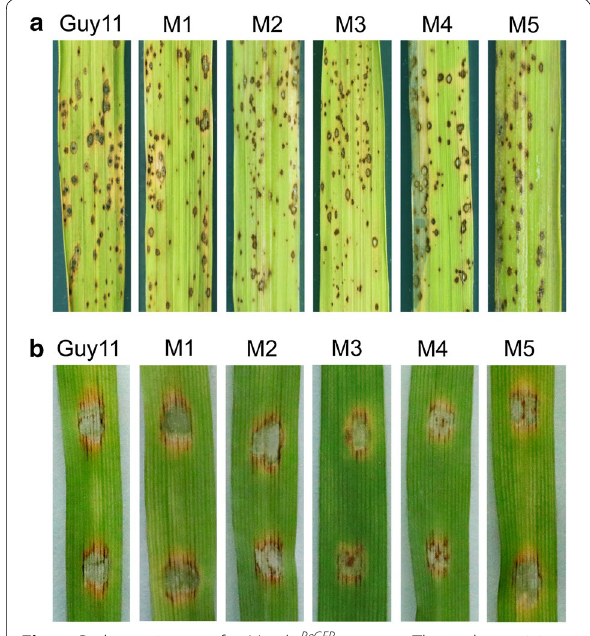
Fig. 4 Pathogenic assay for Mosdi1 ReGFP mutants. The pathogenicity was tested for both wild type Guy11 and Mosdi1 ReGFP mutants, and no significant differences were identified among the strains. a Disease symptoms caused by strains on 14-day-old rice seedlings. b Disease symptoms caused by strains on 7-day-old barley